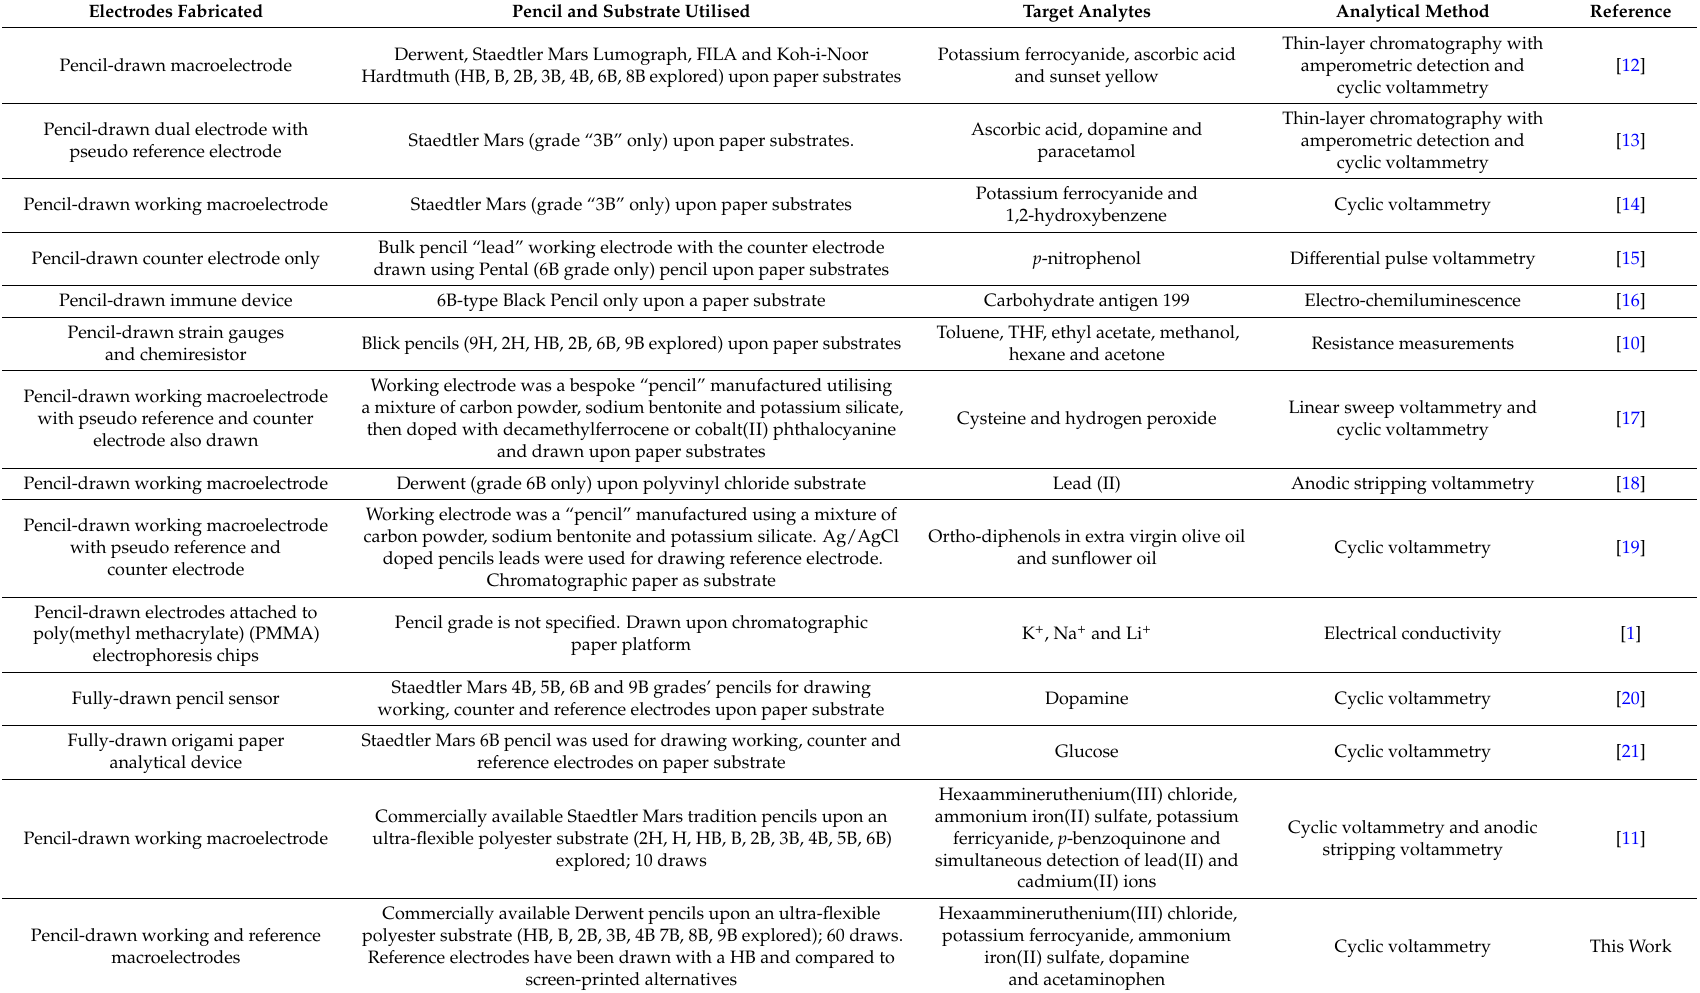
Table 1. Overview of current literature on pencil-drawn electrode systems, in order of publication